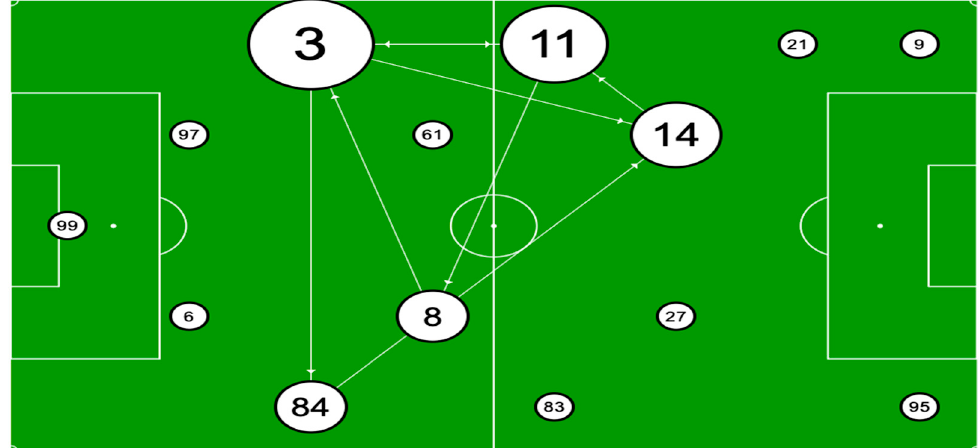
Figure 2. Network display results from team A in the critical event B4 .